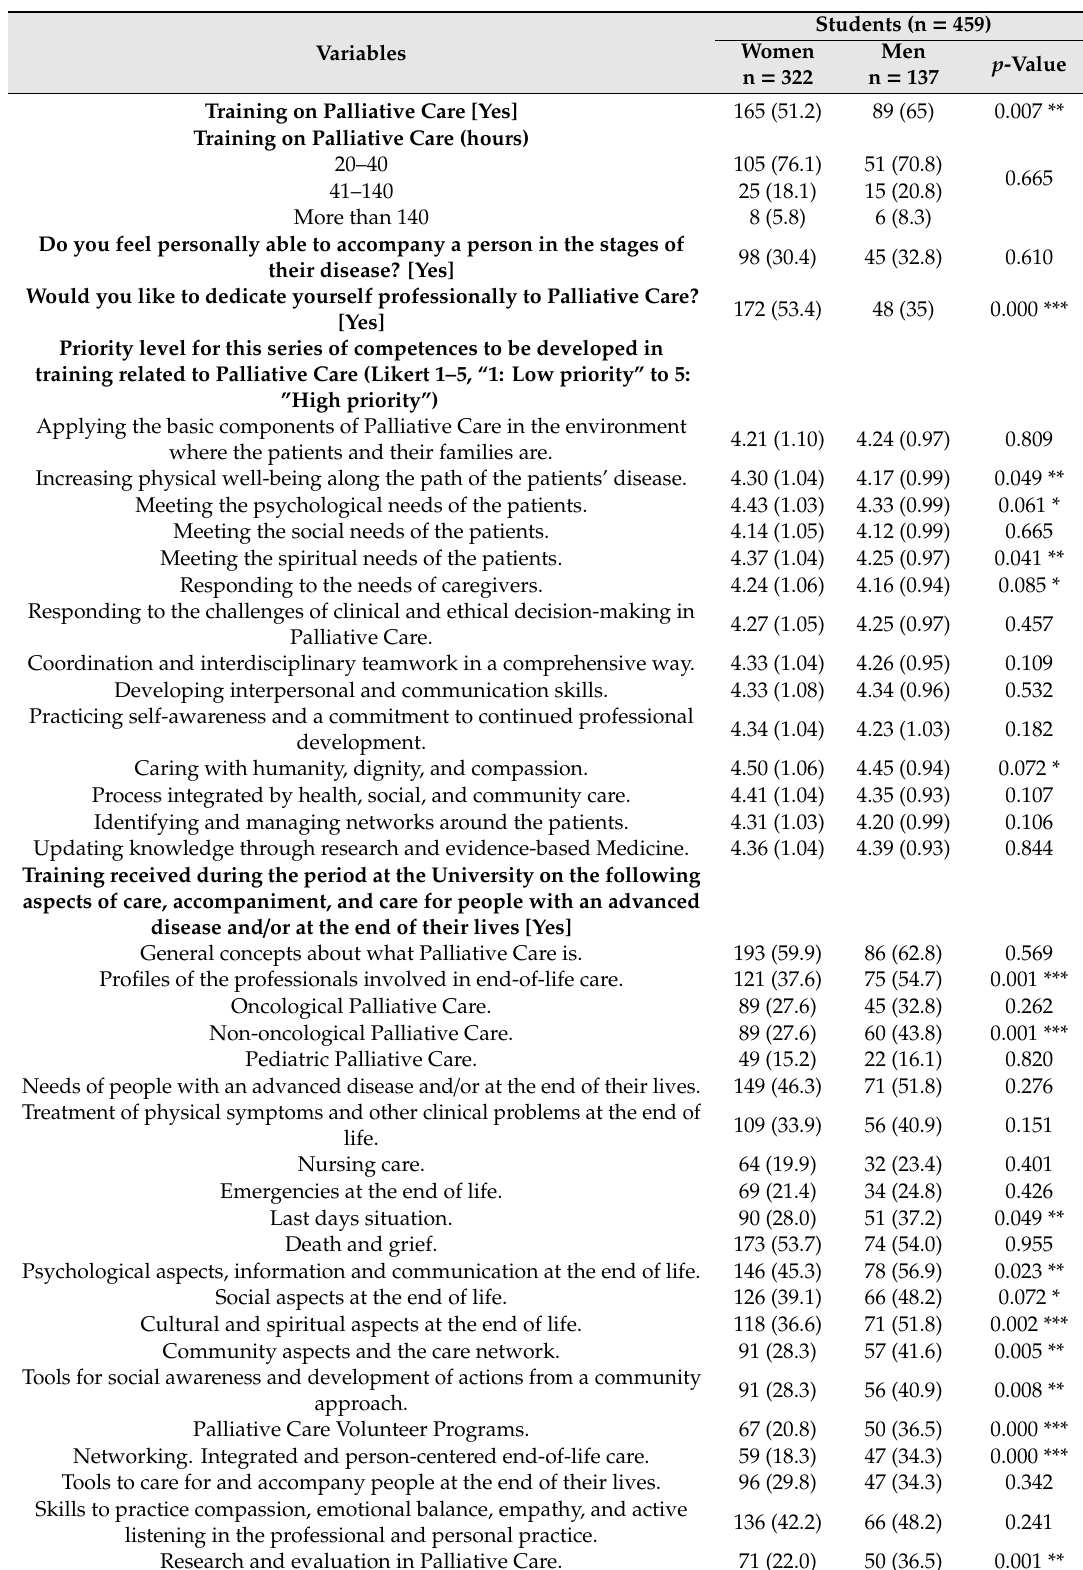
Table 3. Training needs of the students by gender. (n =